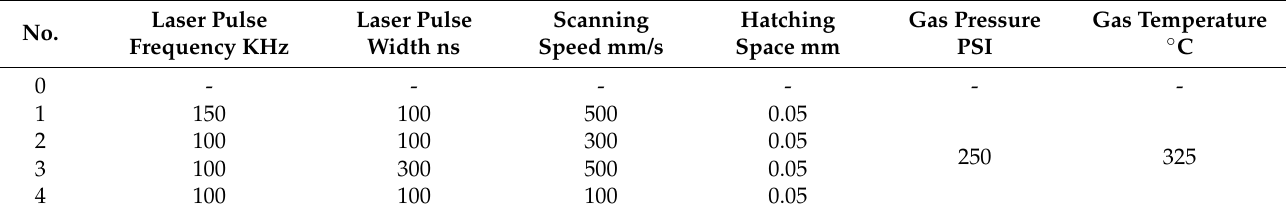
Table 1. Processing